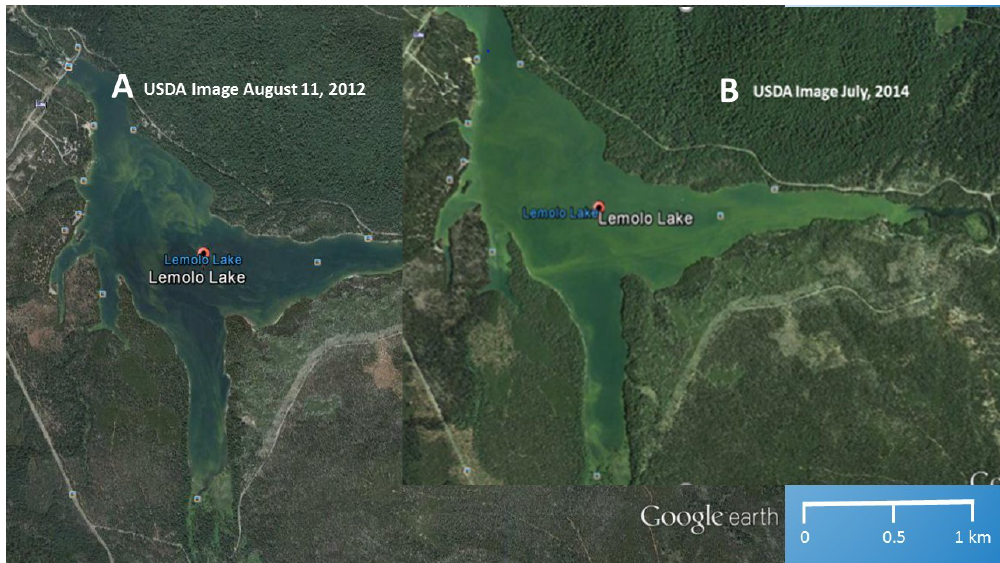
Figure 5. USDA color aerial images of Lemolo Lake, Oregon. Images were taken: ( A ) 11 August 2012 and, ( B ) July 2014. Bright green areas within Lemolo Lake (image B) indicates an extensive cyanobacterial bloom occurring at the time the image was taken. Source: Images obtained from Google Earth.